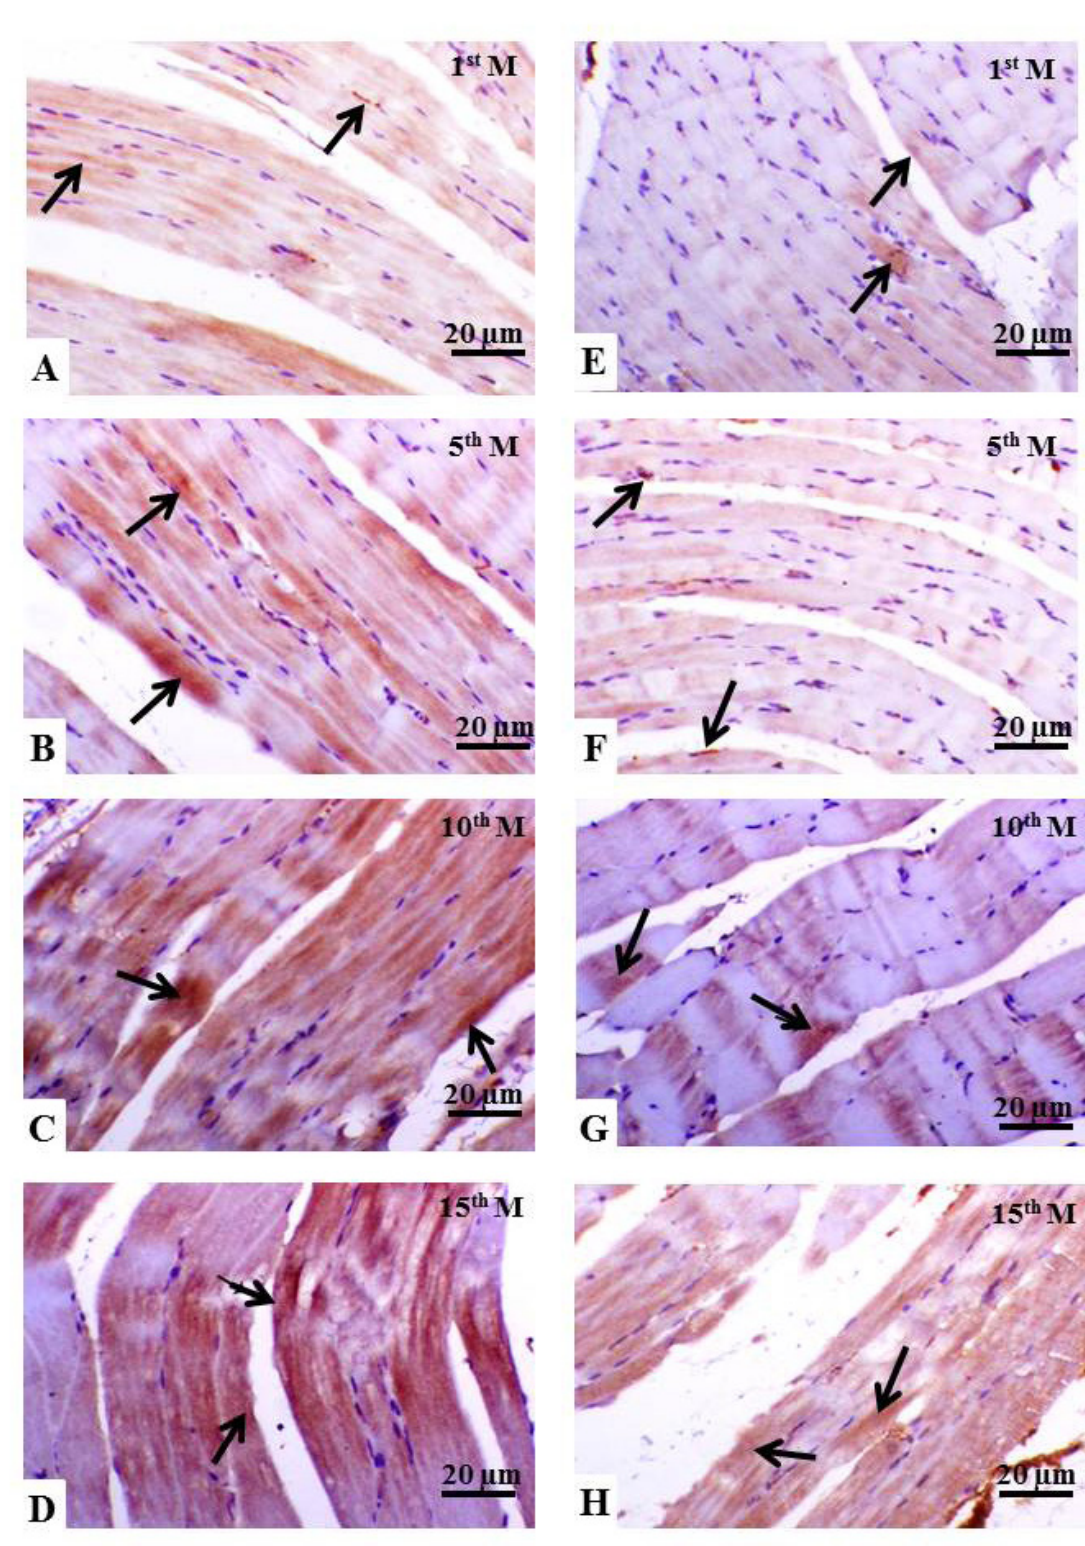
FIGURE 4: L ight photomicrographs of the rats gastrocnemius muscles immunostained with caspase 3 antibodies. (A- D) and (E- H): Rats that were taken a vehicle and quercetin, respectively. 1stM, 5thM, 10thM and 15thM include rats that had 1, 5, 10 and 15 month old, respectively. Note the increase of caspase 3 expressions (arrows) from A to D then the decrease of its expression (arrows) from E to H. Note also the difference in the caspase 3 expression, at the same age, after quercetin